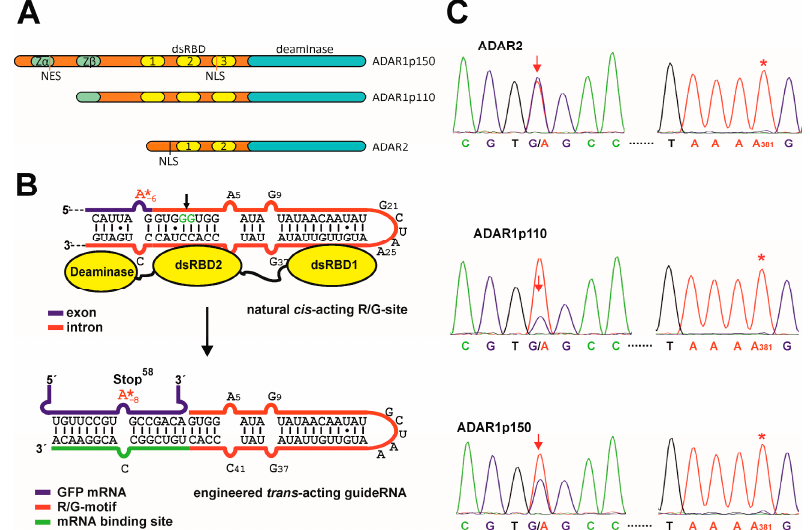
Figure 1. Site-directed RNA editing with R/G-guideRNAs. ( A ) Scheme of the three human ADARs used in this study; ( B ) Design principle: the R/G-guideRNAs have been developed as trans-acting guideRNA from the natural cistronic R/G-motif of the GluR2 transcript. The binding sites of the dsRBDs (dsRNA-binding domains) of ADAR2 are indicated; ( C ) Sanger sequencing of the editing experiments when applying the R/G-guideRNA with ADAR1p110 or p150 compared to ADAR2 in the repair the W58x codon in eGFP. Shown is the sequence around the editing site (arrow) and around a typical off-target site, A381 (*). For full Sanger sequences see Figures S2 and S3.